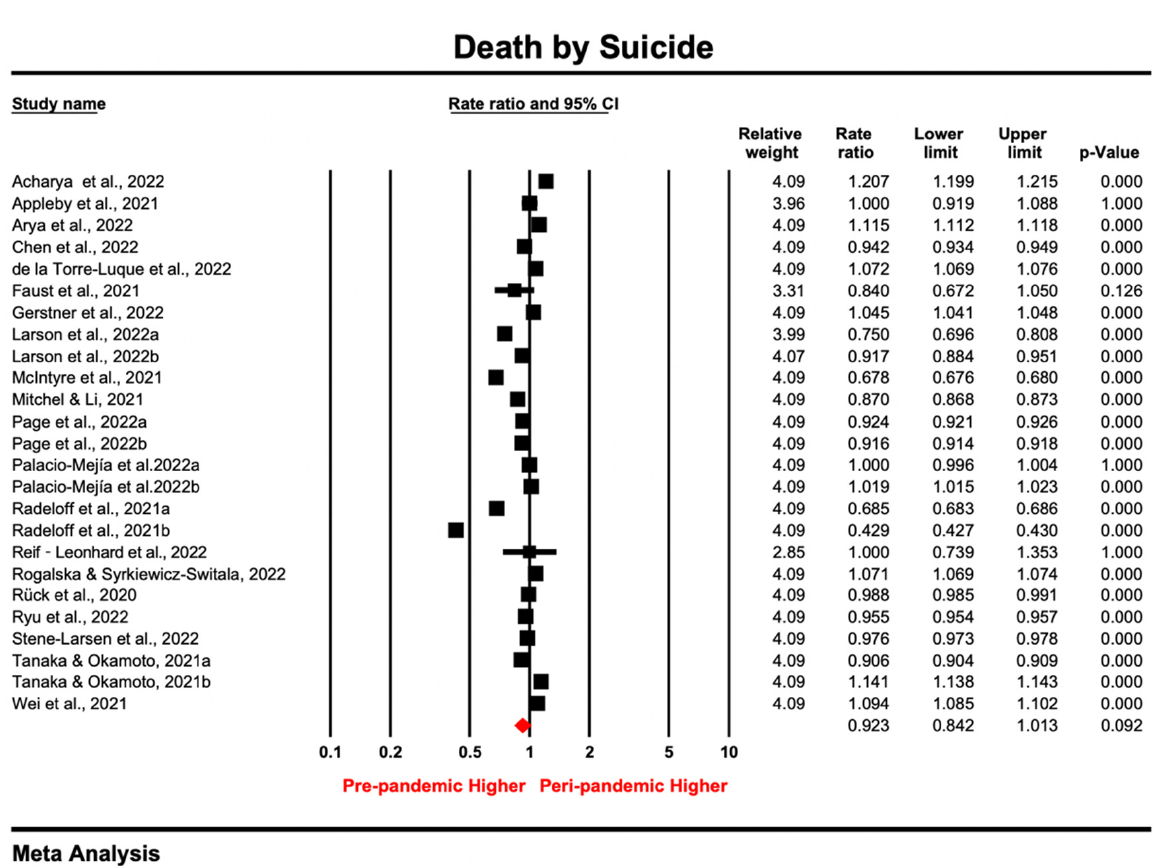
Figure 6. Forest plot for studies [8,13,14,76–84,86–91,113,114] reporting death by suicide (Prismatic colored as red refers to the pooled estimate).